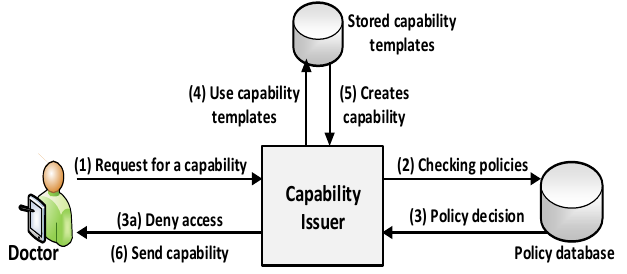
Figure 3. Issuingof a capabilityfroma capabilitytemplate.